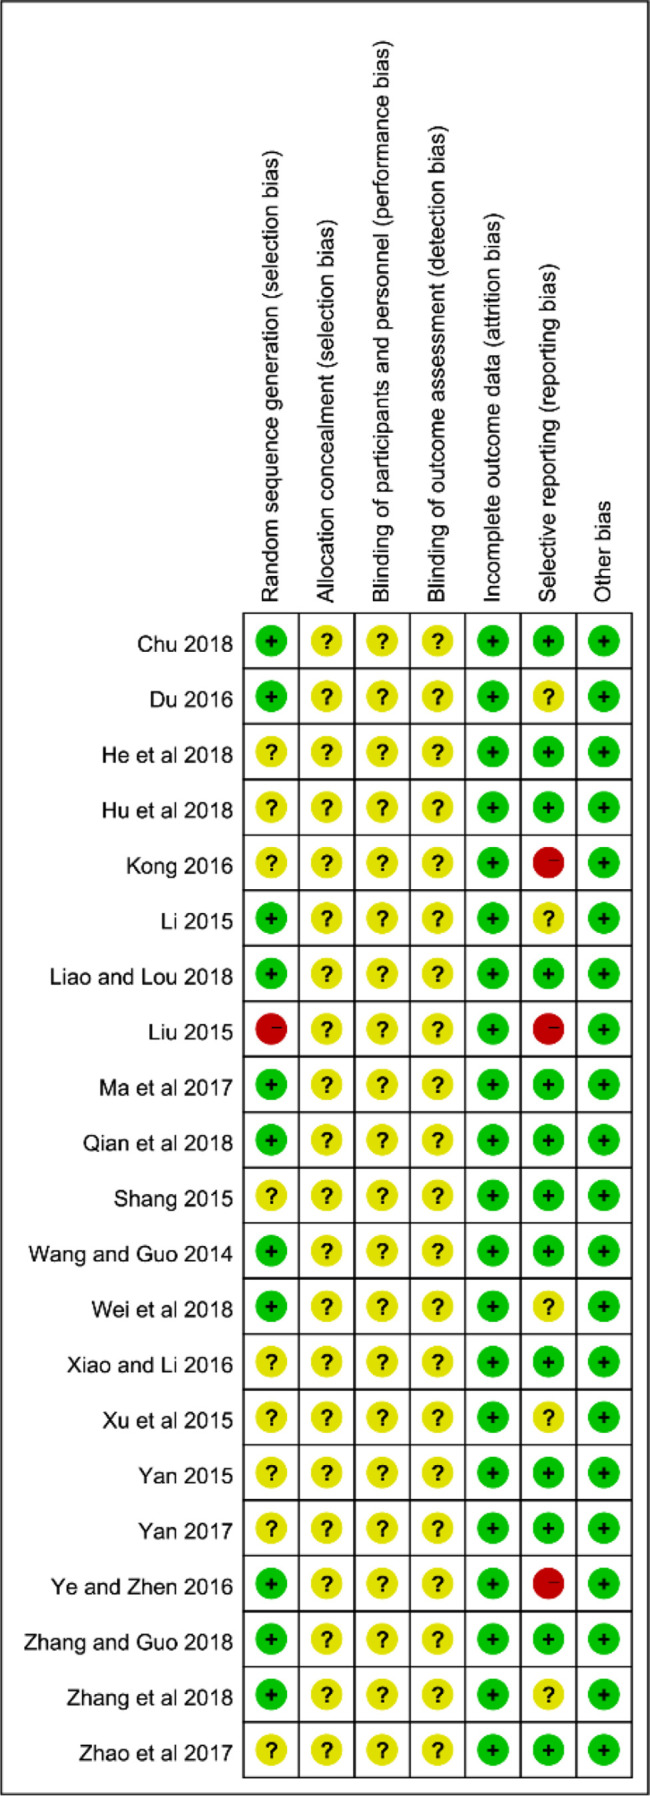
Assessment of risk of bias in the 21 trials.